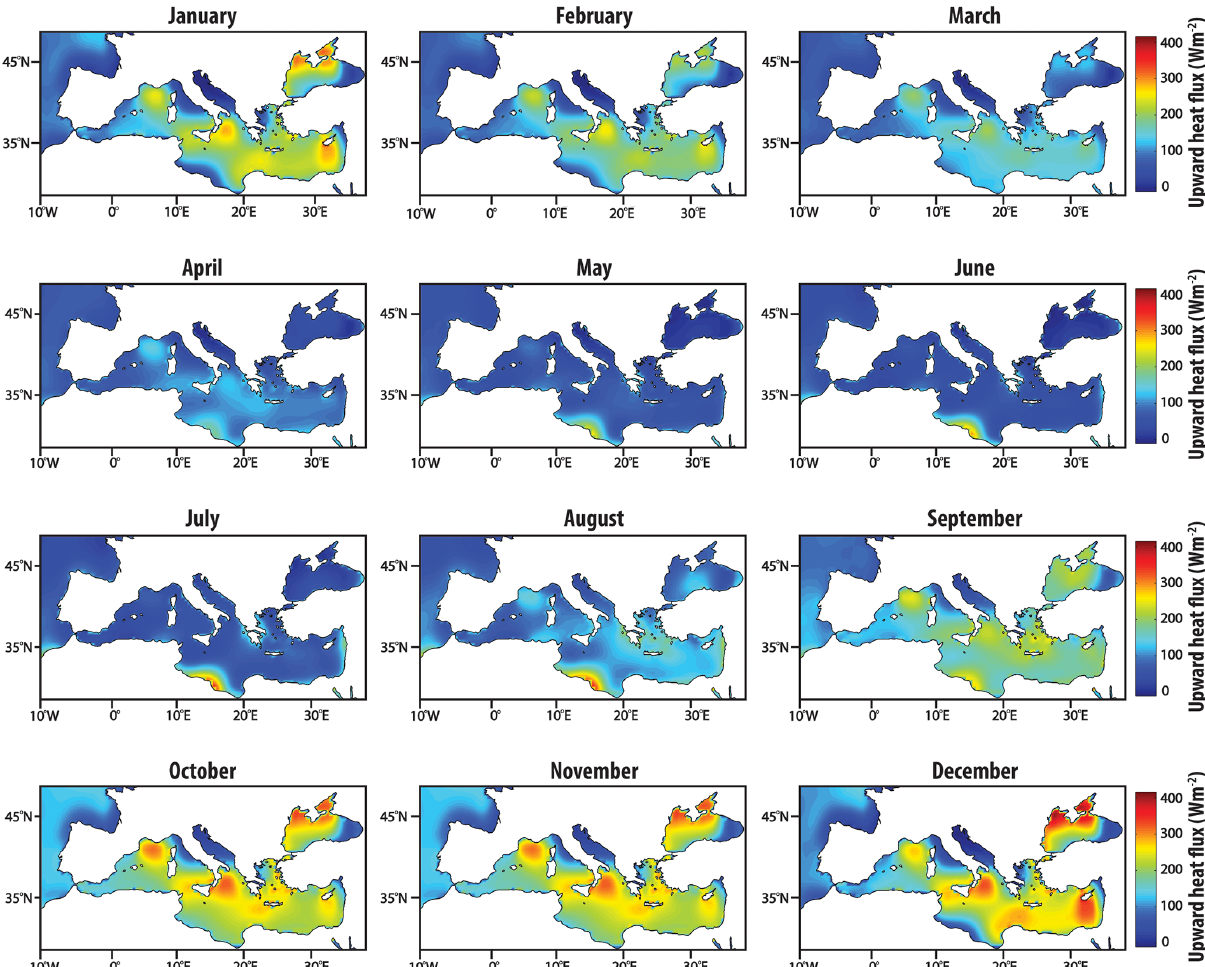
Figure A1. Monthly upward heat flux for MM5-ECHO-G paleosimulations for the last 1000 years identify September–February interval (autumn–winter) as the period contributing to most of the annual upward heat flux. Air–sea exchanges during this winter-centered half of the year span the main period for deep-water formation. In this study, for convenience this period is referred to as winter (although it contains the outlying months of September and October, which lie outside of a typical